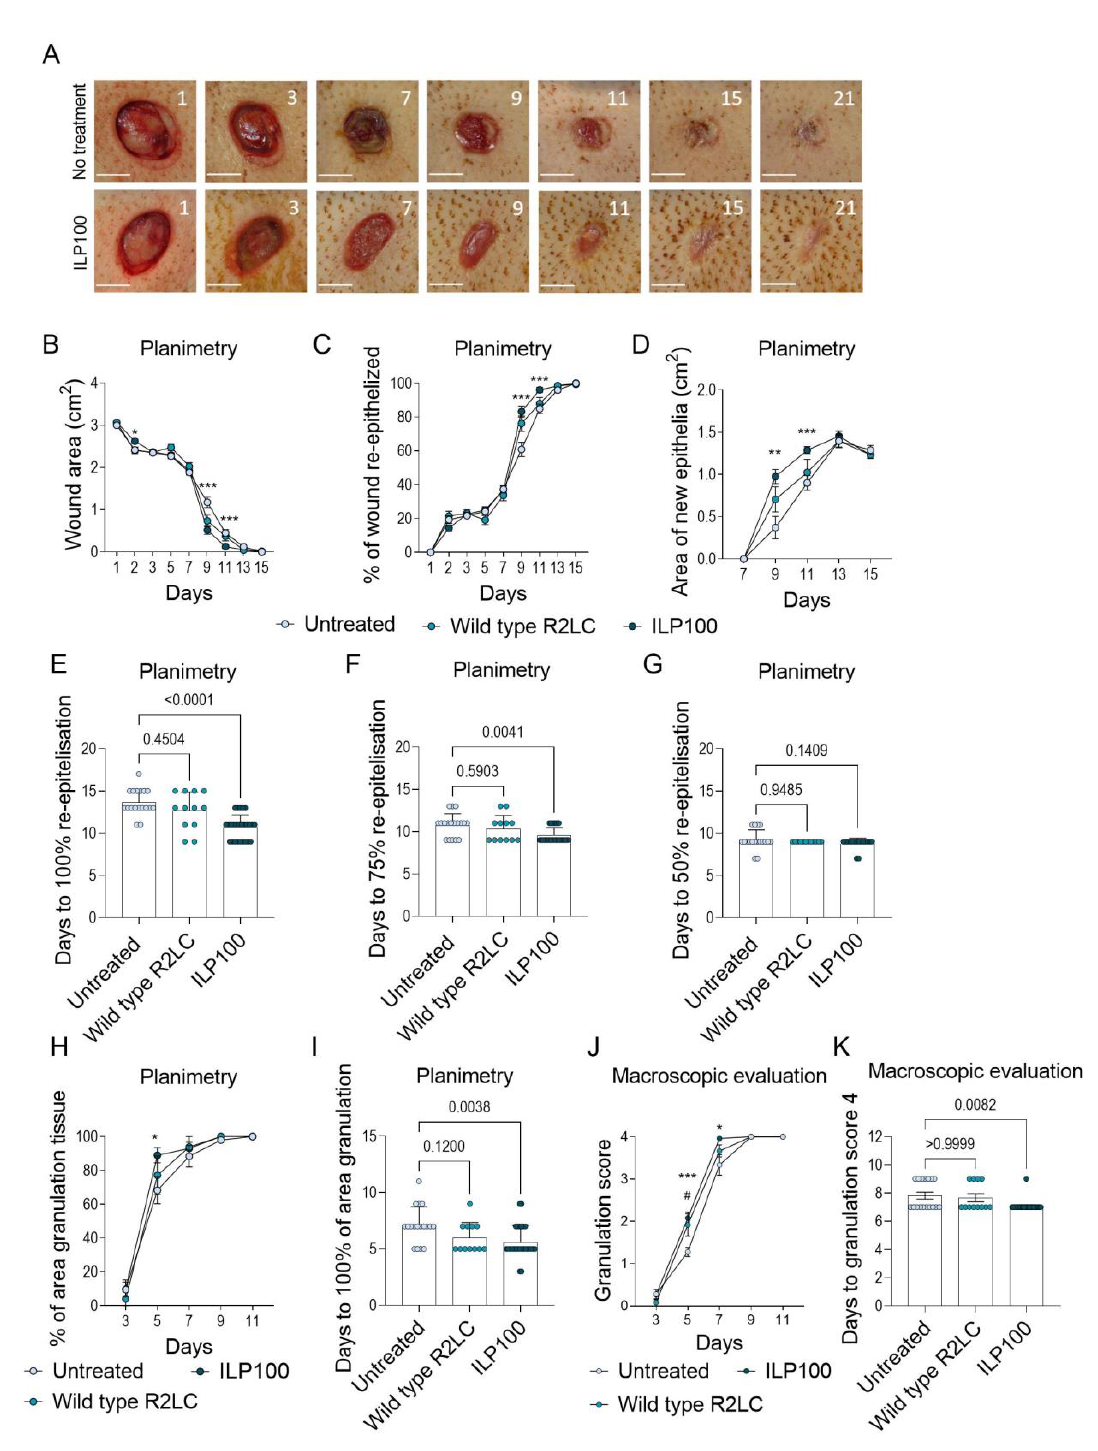
Figure 3. Wound healing assessed by planimetry and macroscopic evaluation in cohort A. ( A ) shows representative photographs of healing over time where the inserted numbers depict days post-induction and the scale bar corresponds to 1 cm. Wound healing was assessed by planimetry detecting wound area ( B ), % of the wound being re-epithelized ( C ), and area of newly formed epithelia over time ( D ). Days to 100% ( E ), 75% ( F ), and 50% ( G ) re-epithelization of the wounds were also assessed. In addition, granulation tissue formation was measured as wound area covered by granulation tissue ( H ) and days to 100% of the wound area being covered by granulation tissue ( I ) using planimetry, as well as macroscopically as granulation score (0–4) day 3 to 11 ( J ) and days